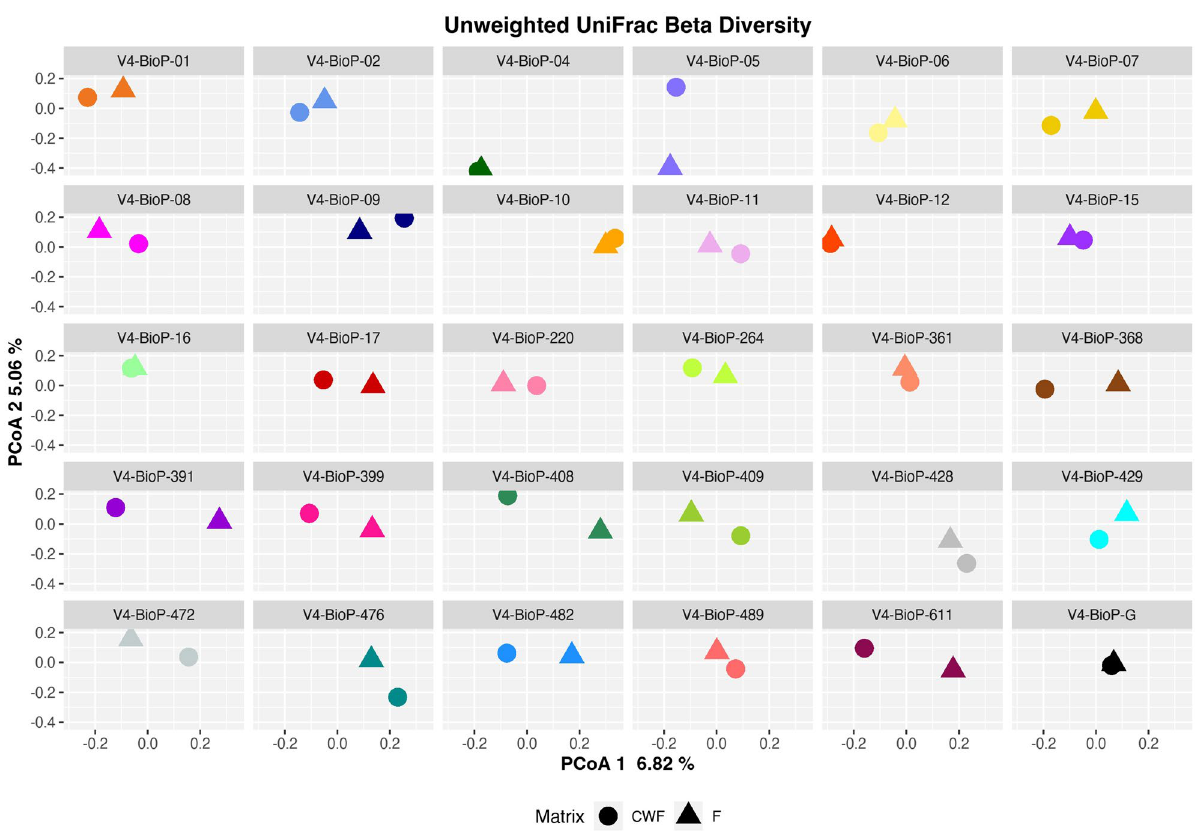
Figure 3. PCoA of unweighted UniFrac distances between paired F and CWF samples for the subjects dataset. Point shape and colors represent the sampling matrix and the enrolled subject,